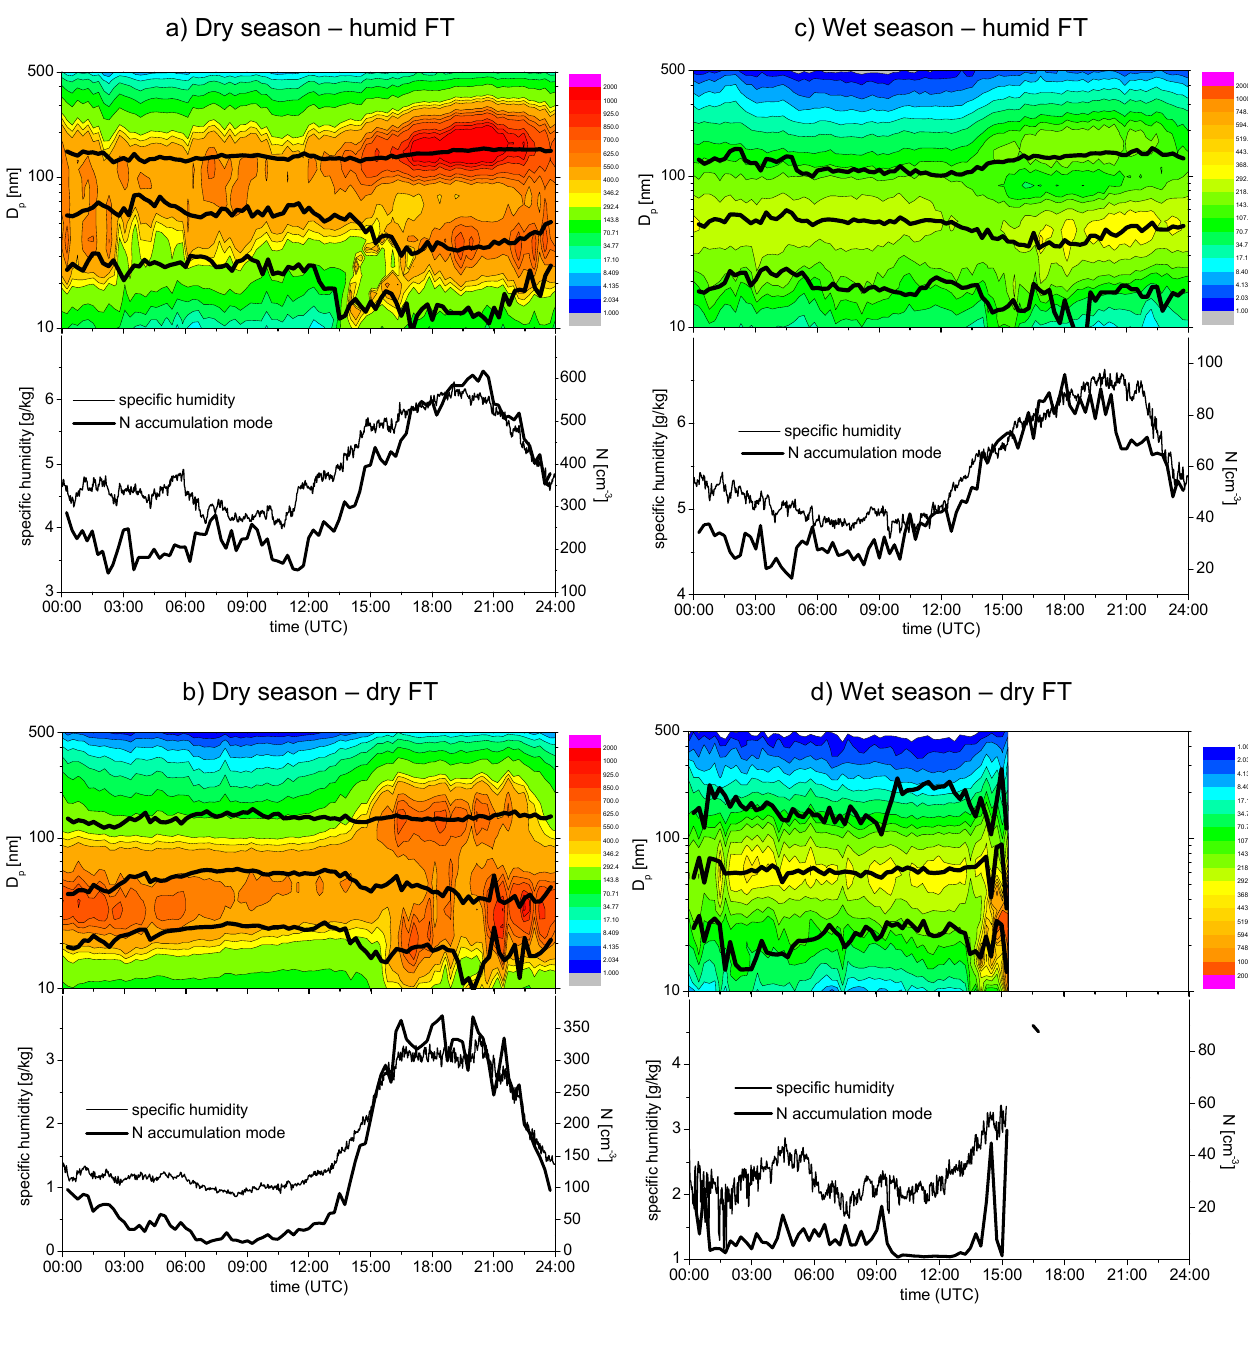
Fig. 6. Mean diurnal cycles of particle number size distributions for 2008. The data is keyed after dry season (a, b) and wet season (c, d) , as well as humid FT aerosol (50% ≤ RH ≤ 95%) (a, c) and dry FT aerosol (RH < 50%) (b, d) . The black lines in each upper graph indicate the corresponding geometric mean diameters of the accumulation, Aitken and nucleation modes. Each bottom graph shows the mean diurnal cycle of accumulation mode number concentration and specific